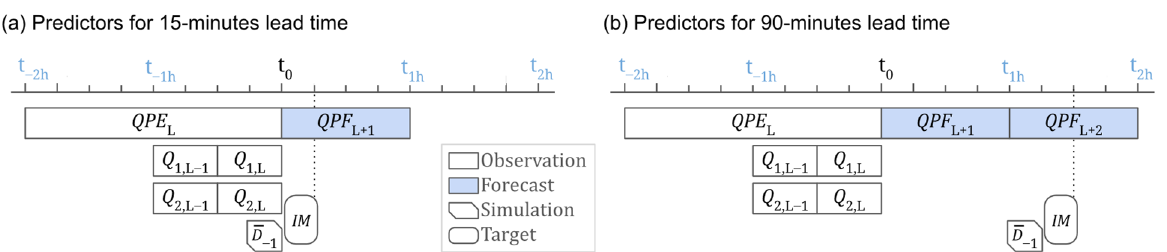
Figure 6. Temporal representation of the predictors of the NARX models trained for lead times of ( a ) 15 min and ( b ) 90 min assuming an issue time t 0 Table 3. Listing of all potential NARX predictors.